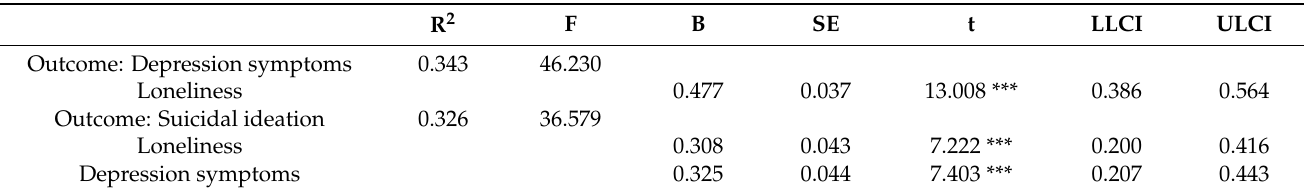
Table 3. Mediation effect of depressive symptoms ( n =